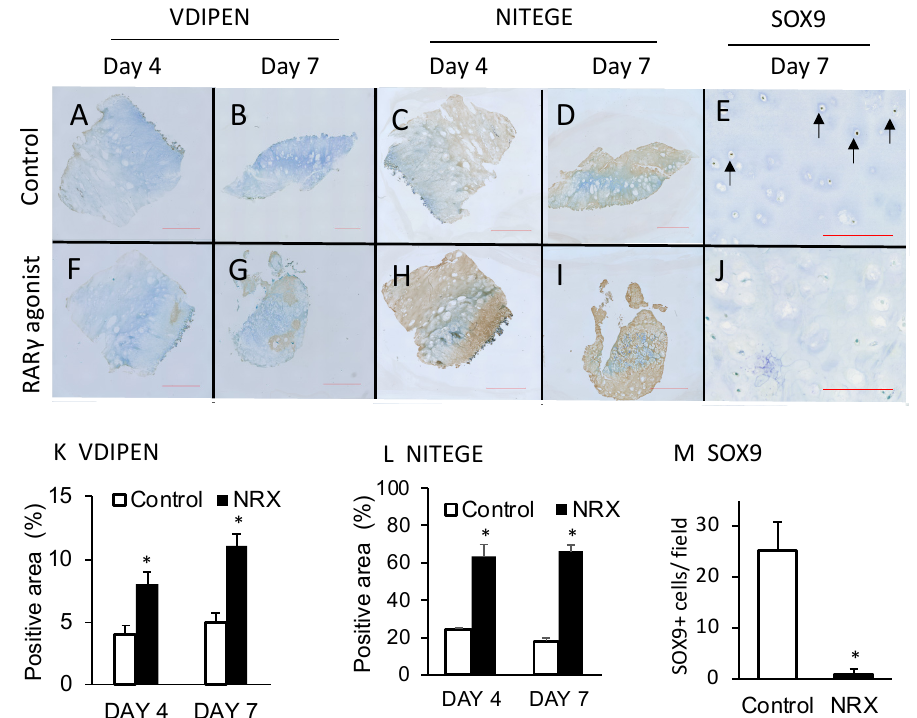
Figure 5. Stimulation of aggrecan degradation and inhibition of SOX9 expression by RAR γ agonists in osteochondroma explant cultures. The osteochondroma explants were treated with vehicle (Control, 0.1% ethanol) ( A – E ) or 300 nM NRX204647 (RAR γ agonists) ( F – J ) in DMEM containing 2% charcoal-treated FBS ( n = 3). The explants were fixed with 4% PFA 4 or 7 days after treatment and subjected to immunohistochemical staining using anti- VDIPEN , NITEGE or SOX9 antibodies. The staining results were quantified by Cell Hybrid Count function in BZX-700 ( Κ – M ) The values are average and standard deviation (SD). * p < 0.05 versus control. Bars are 2 mm for A-I and 200 μ m for E and J.